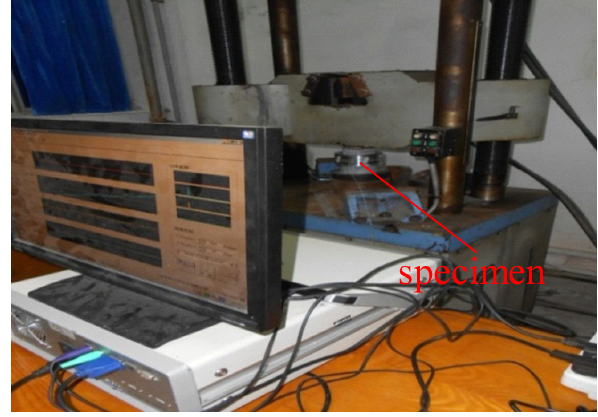
Figure 7: Measurements during the pushing process